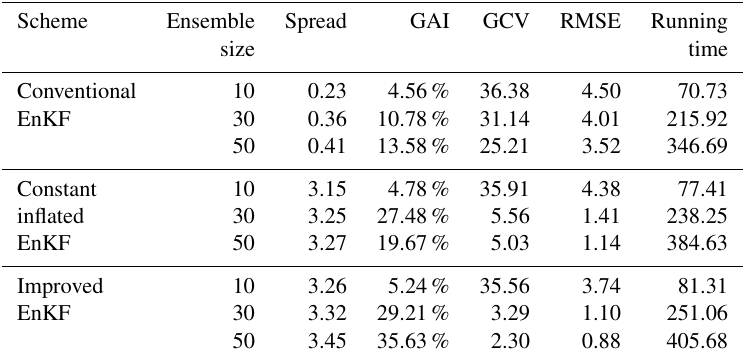
Table 1. Time-mean values of the forecast ensemble spread, GAI statistics, GCV functions and analysis RMSE over 2000 time steps, as well as the running times (second) for different assimilation schemes. The observation number is 40 and the ensemble size is selected as 10, 30 and 50,